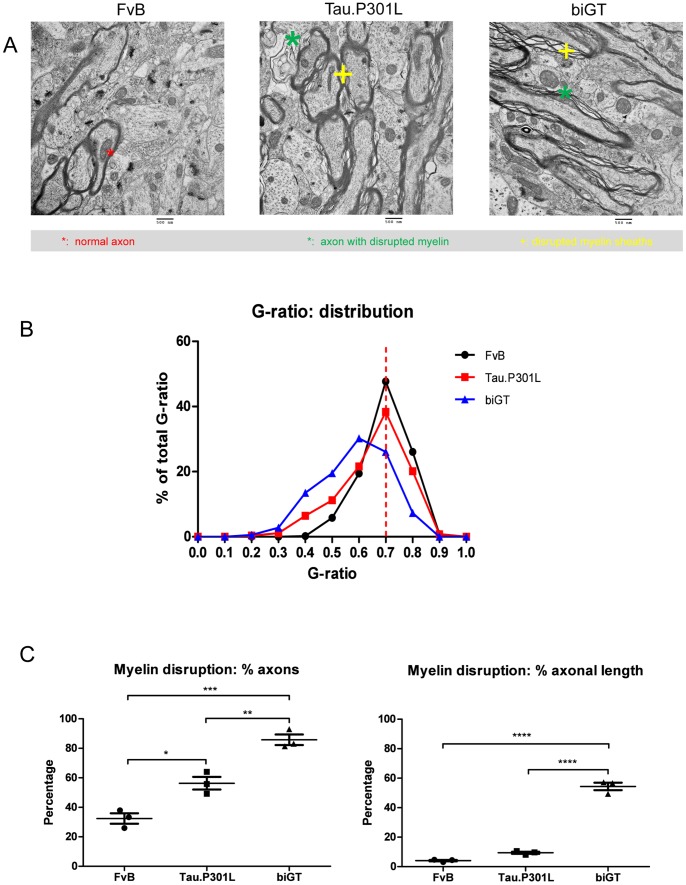
Myelin defects in SLM of Tau.P301L mice.A. Representative images of the ultrastructure of myelinated axons in wild-type, Tau.P301L and biGT mice, with myelin defects indicated by the symbols explained in the caption. B. G-ratio distribution of TA axons in SLM in wild-type FvB, Tau.P301L and biGT mice (see also Table 2). C. Quantitation of axons harboring morphological defects (left panel) and of axonal length with disrupted myelin sheaths (right panel) in TA axons of SLM in the three genotypes. Data are mean±SEM, statistically analyzed by one-way ANOVA followed by Bonferroni Multiple Comparison Test post hoc test; *p<0.05, **p<0.01, ***p<0.001.